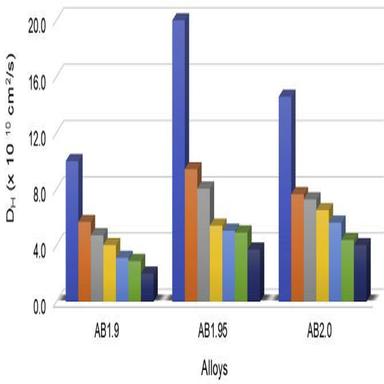
Hydrogen diffusion coefficient (DH) for the studied alloys as related to the cycles number at 50% SoC. The smallest decrease of hydrogen diffusion coefficient vs. cycle number is observed for AB2.0 alloy.